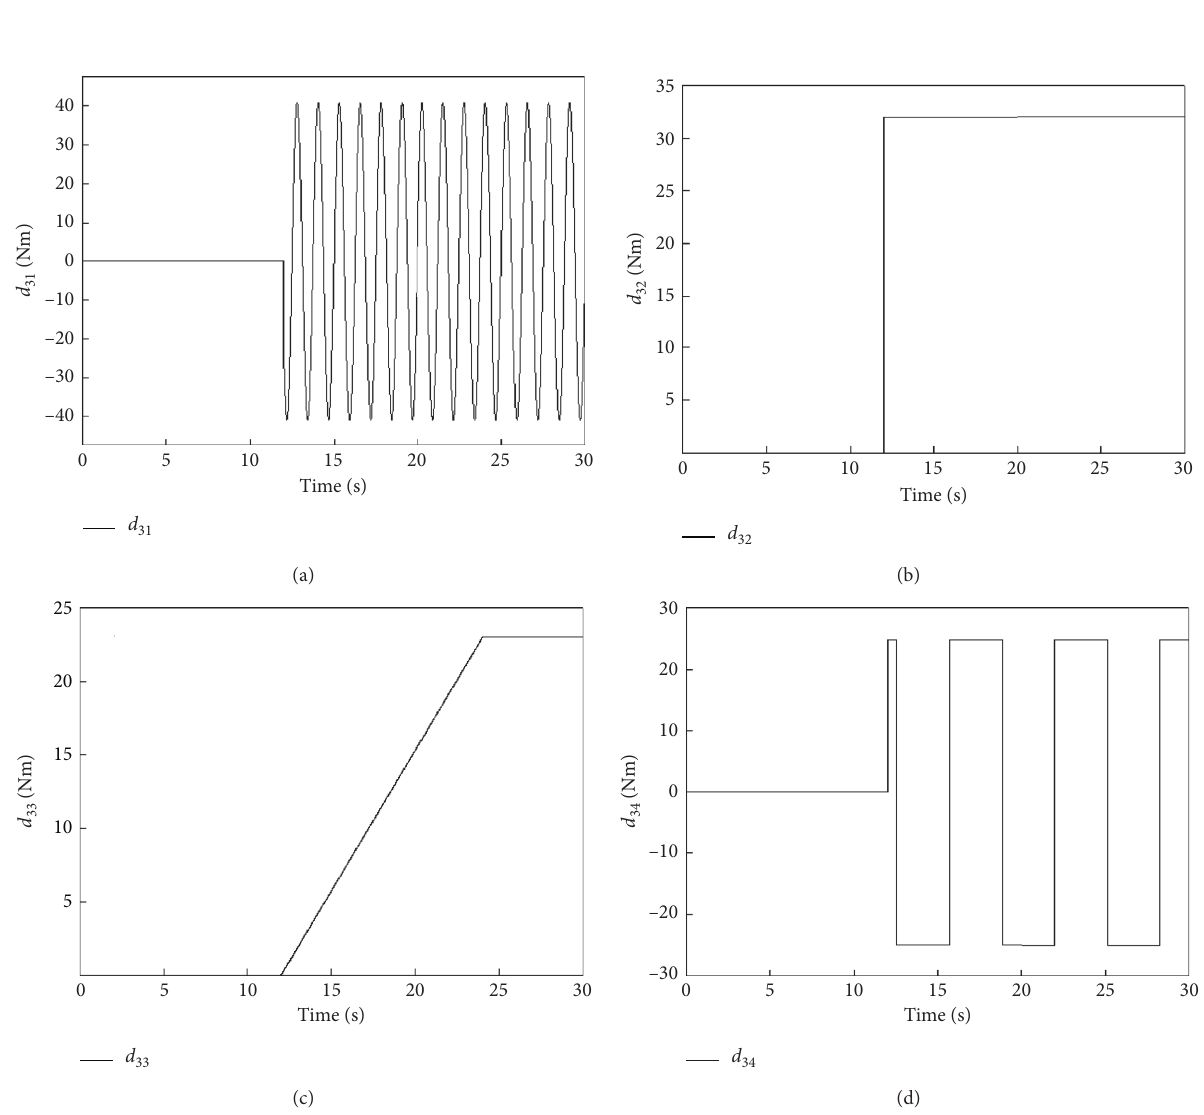
Figure 2: Four types of noise signal superimposed on four motors. (a) Interference signal 1. (b) Interference signal 2. (c) Interference signal 3. (d) Interference signal 4.